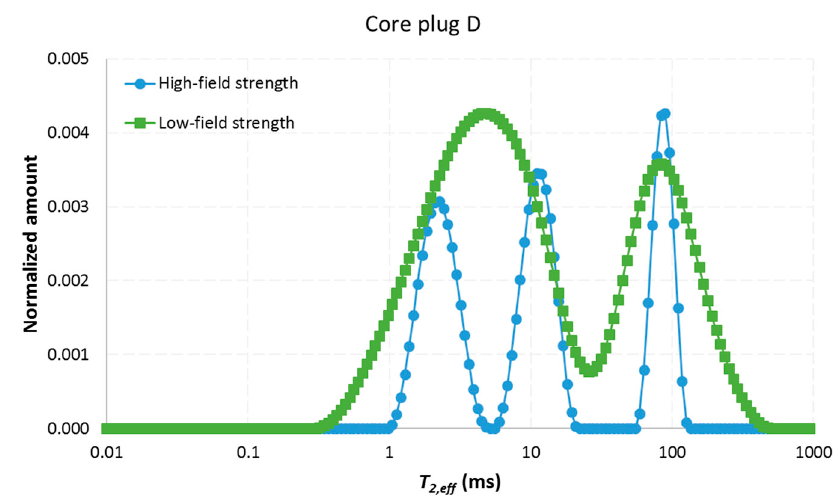
Figure 10. Transverse relaxation distribution for core plug D obtained by the CPMG sequence at high-field strength, B 0 = 4.70 T, and low-field strength, B 0 = 0.28 T. The low-field distribution is normalized with respect to the bulk water distribution, and the sum of the data points is a measure of the porosity of the core plug. The high-field distribution is scaled to the amplitude of the low-field distribution.